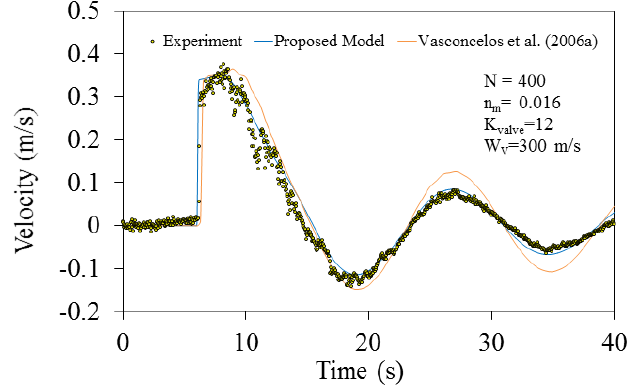
Figure 6. Comparing numerical and experimental velocity time histories at 9.9 m from the upstream tank.